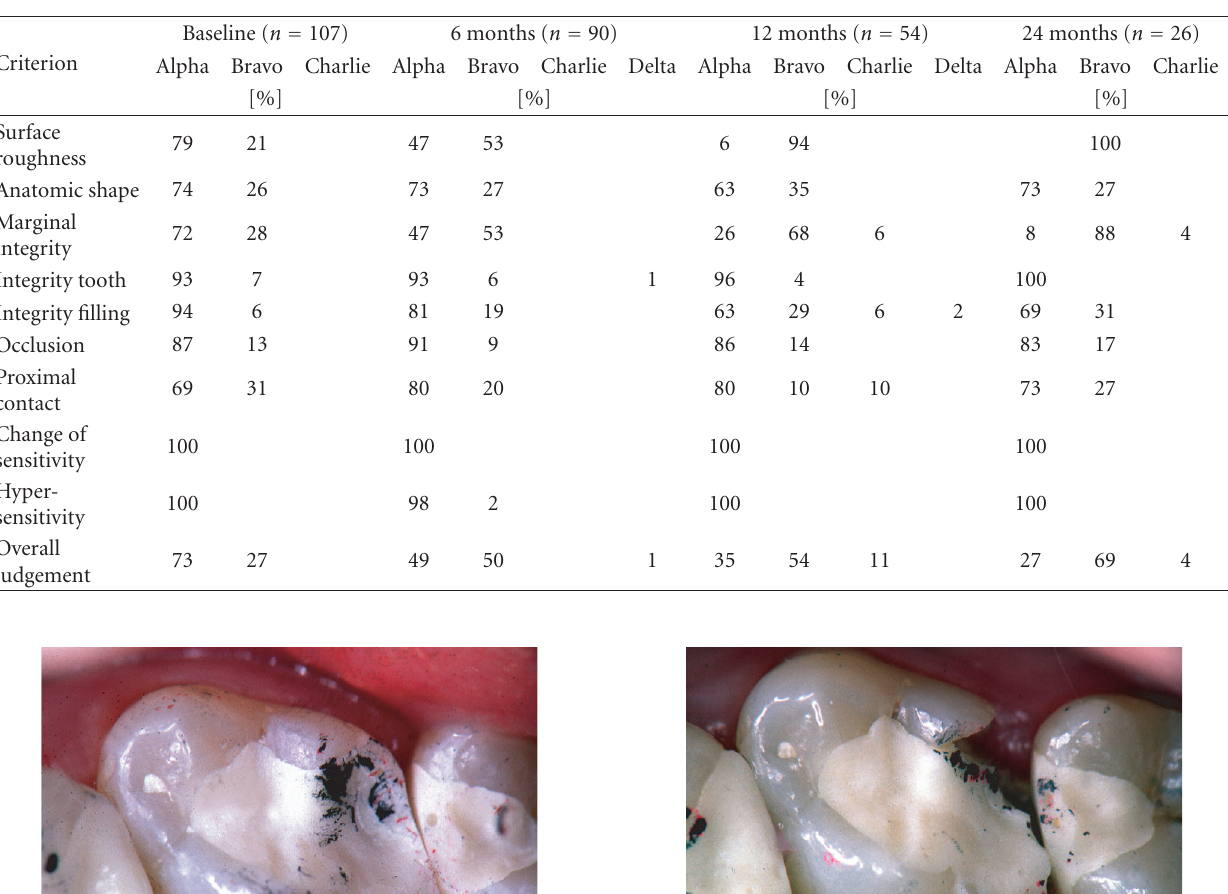
Table 1: Descriptive statistics for all Ketac Molar restorations.